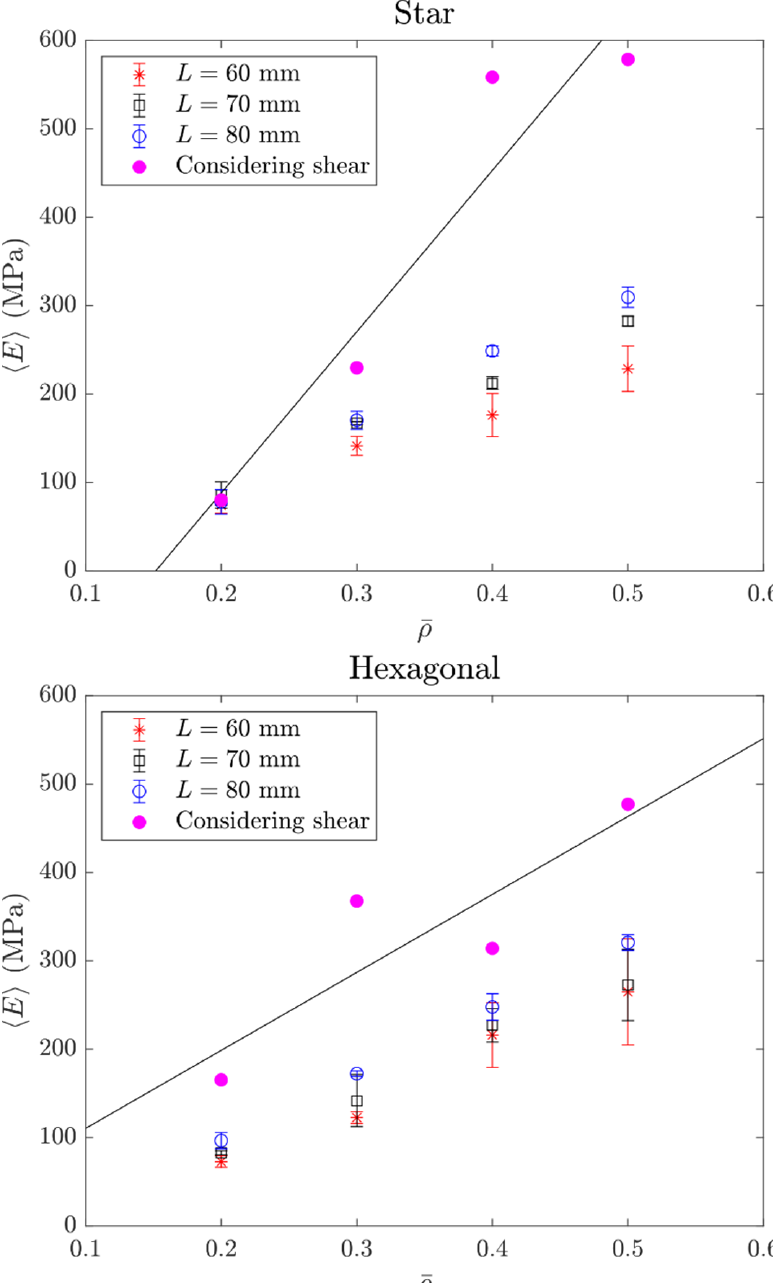
Figure 7. Effective Young’s modulus vs. relative (infill density).